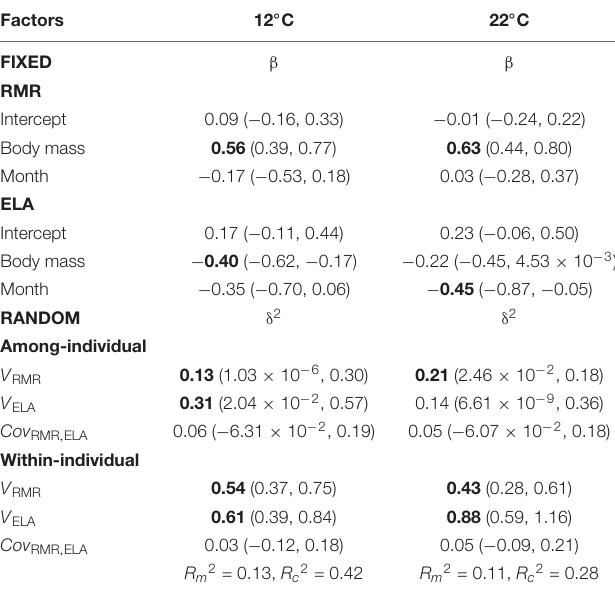
TABLE 1 | Parameters [estimates with 95% credibility intervals (CI)] of multivariate mixed models examining co(variation) between resting metabolic rate (RMR) and exploratory locomotor activity (ELA) in juvenile Alpine newts ( Ichthyosaura alpestris ) at two body temperatures.